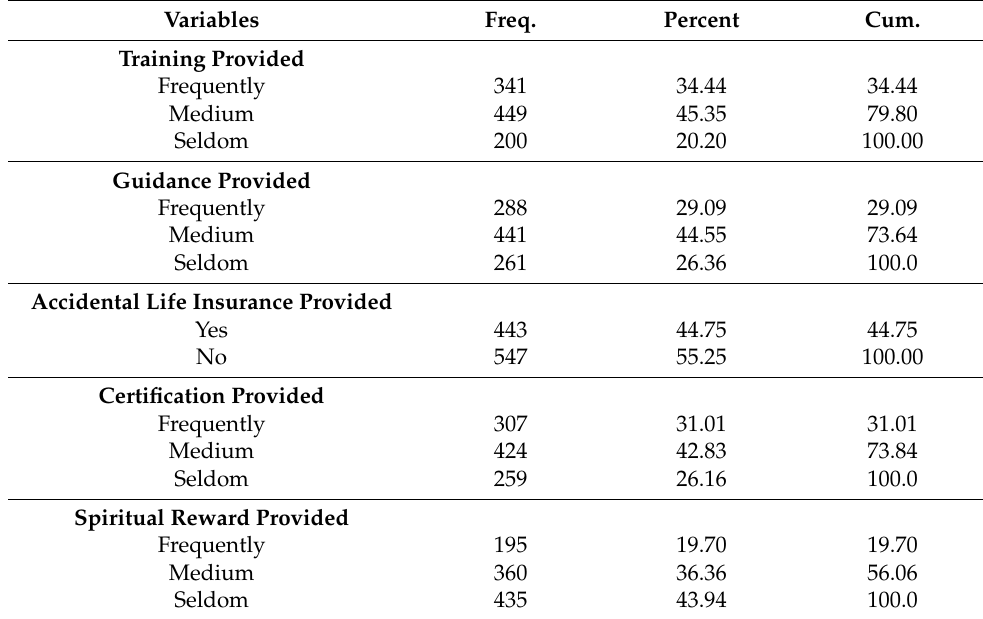
Table 3. Organizational variables of the respondents (%).